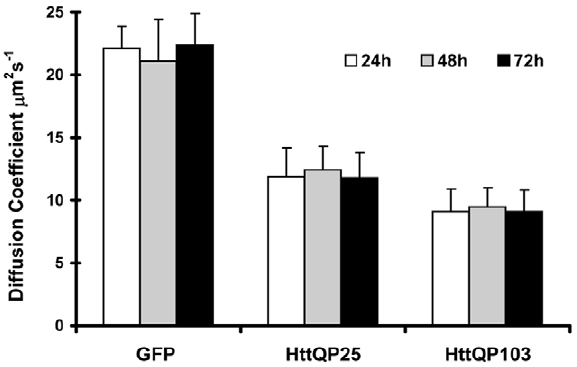
Figure 2. Time of expression does not affect the diffusion coefficients of GFP, HttQP25 and HttQP103. FCS measurements were made 24, 48, and 72h after transfecting the cells. Diffusion coefficients and standard deviations were calculated as described in Figure 1. Student’s t test showed duration of expression had no significant effect on the measured diffusion coefficient.